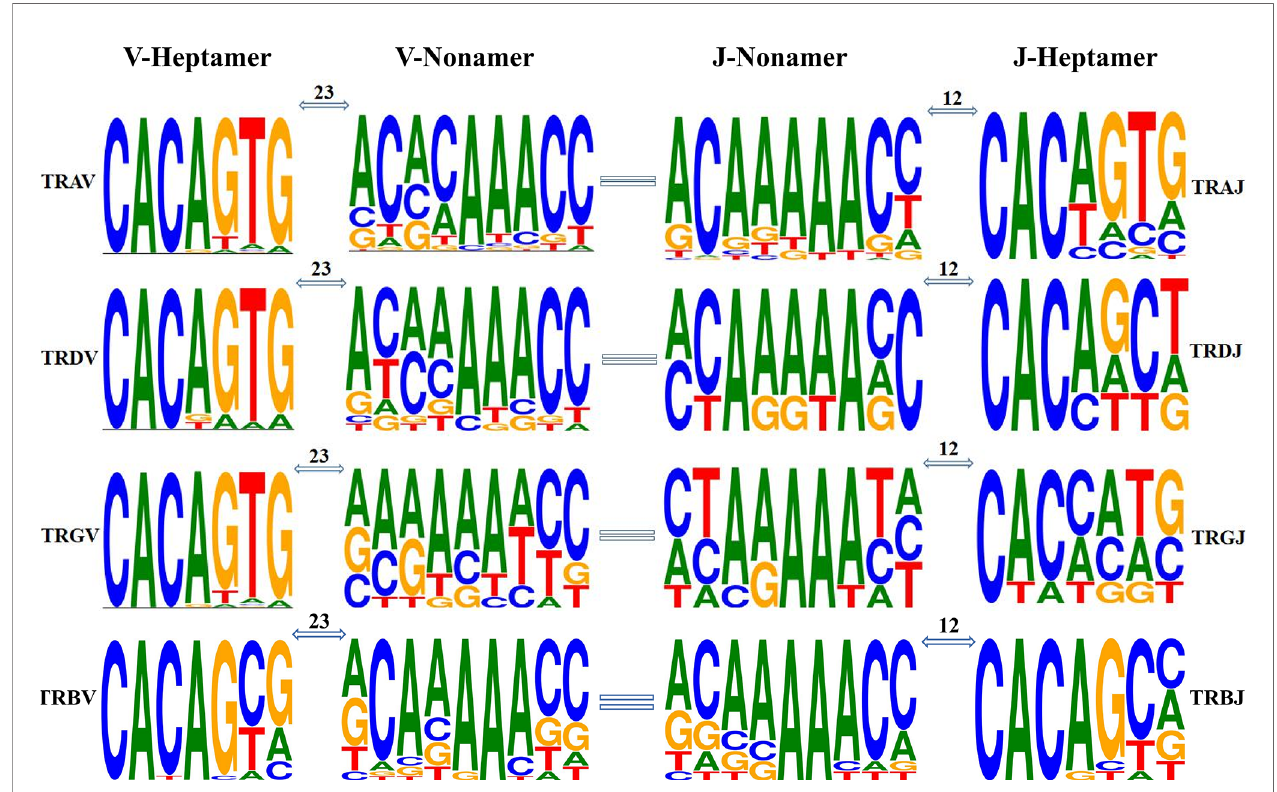
FIGURE 9 | Position weight matrixes of recombination signal sequences of T-cell receptor V and J genes. The height of symbols indicates the relative frequency of each nucleotide at that